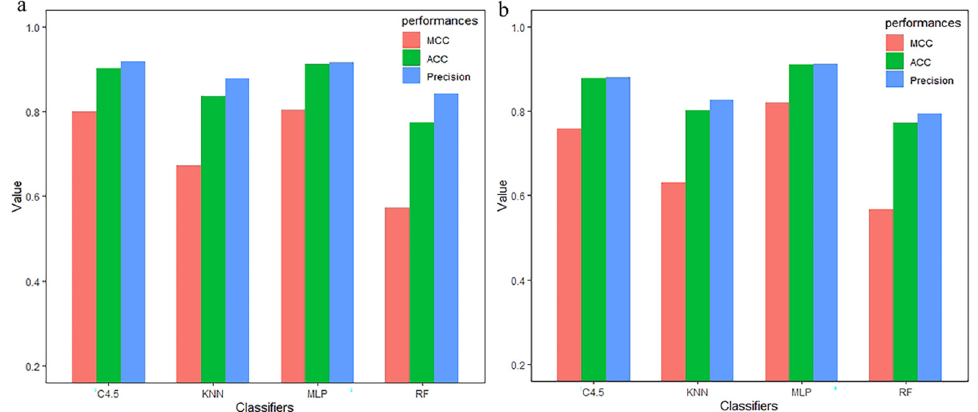
Figure 7. The performance evaluation of two independent test sets through the CC–PSSM feature extraction method to identify key features under different classifiers ( a , b ).